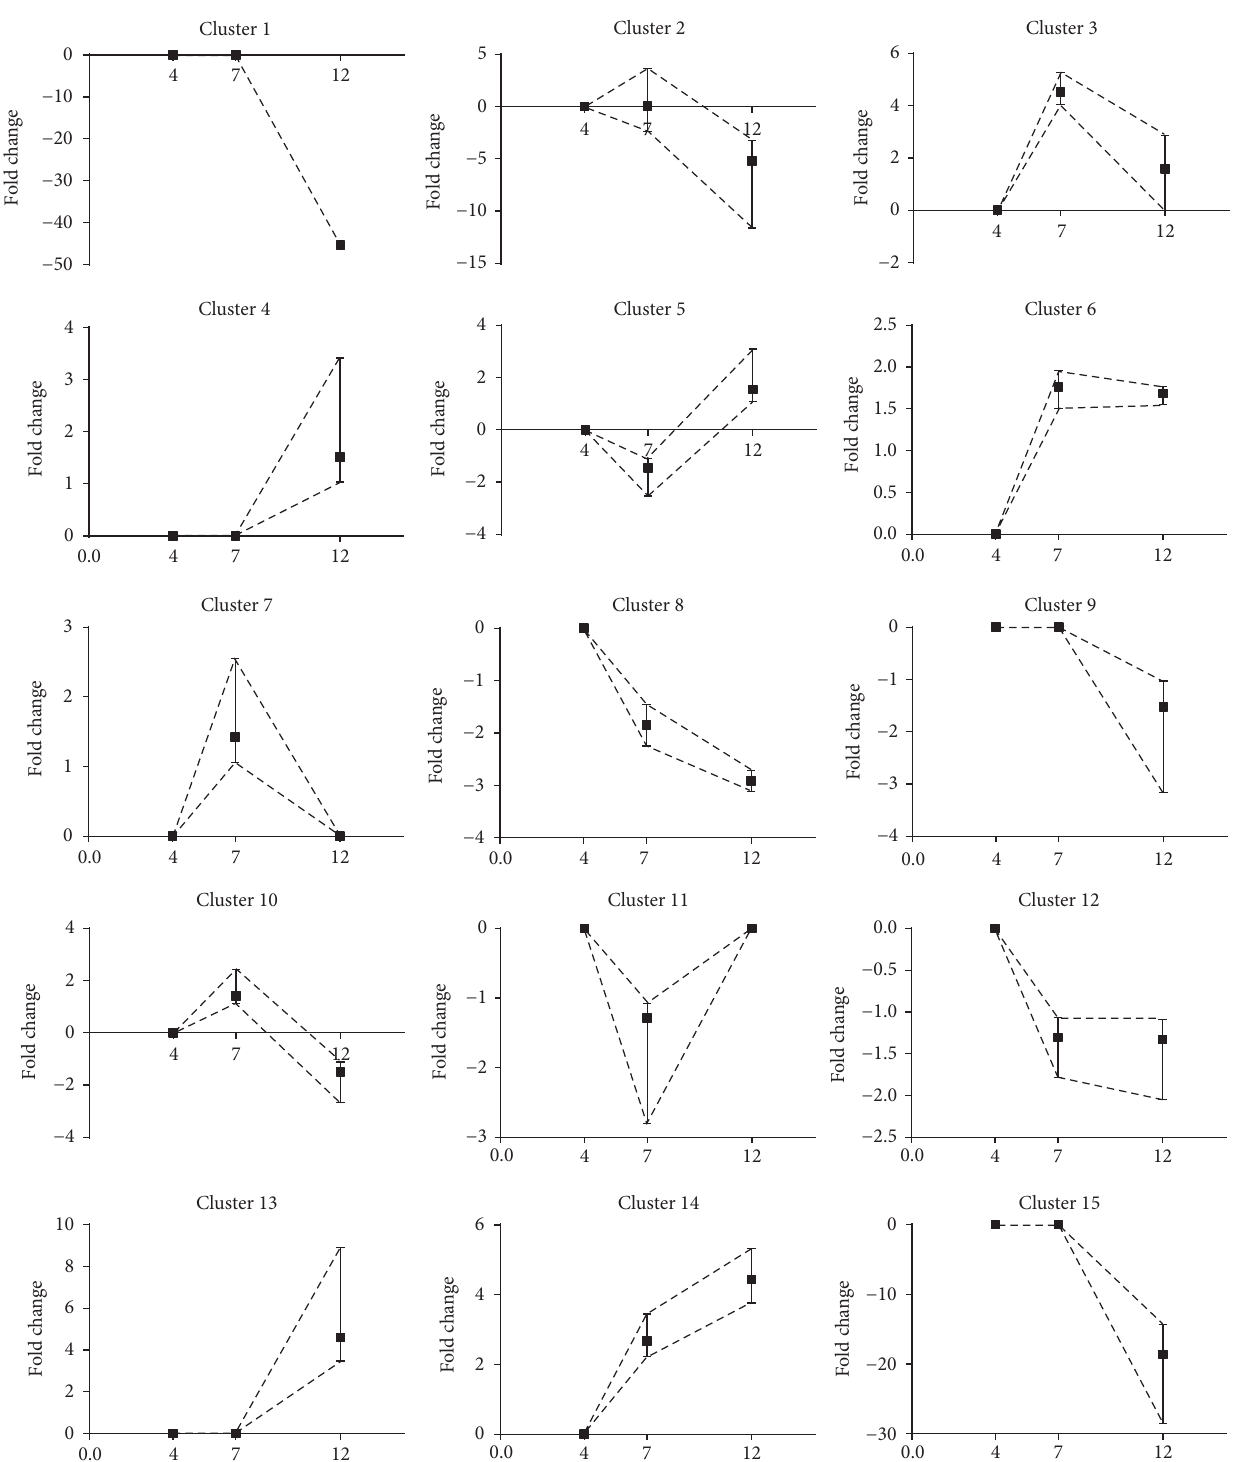
Figure 3: Cluster analysis according to changes in gene expression from day 4 to day 7 and from day 7 to day